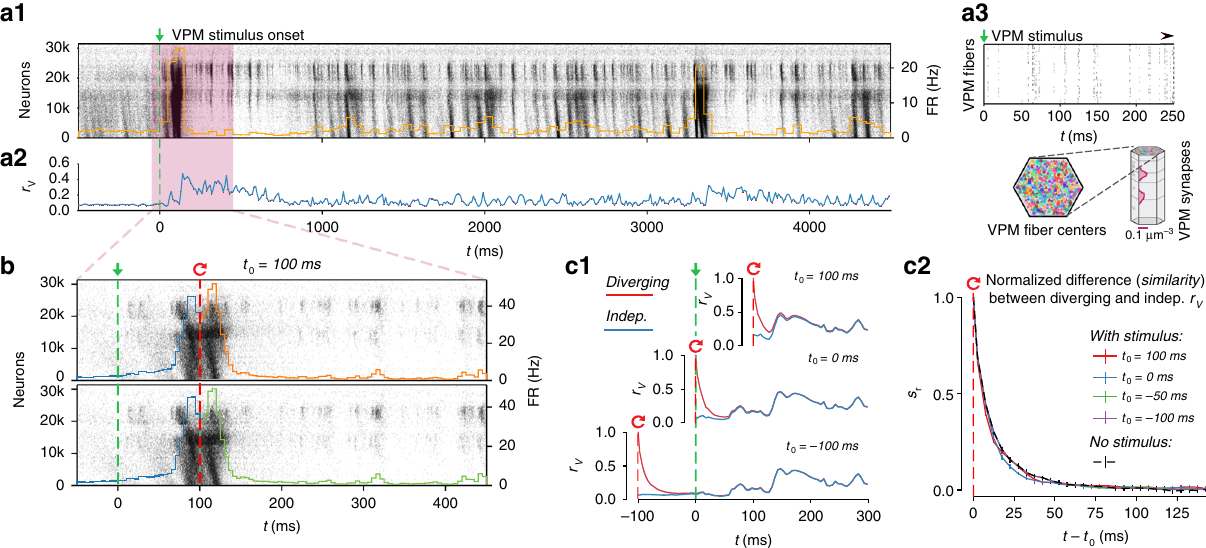
Fig. 5 Rapid divergence of evoked, reliable activity. a1 Population raster plot and population peristimulus time histogram (PSTH) for all 31,346 neurons in the microcircuit, during evoked activity with a thalamic (VPM) stimulus. Neurons are ordered according to cortical depth, with deep layers at the bottom and upper layers at the top, and each row representing the spikes of one neuron. For visibility, raster lines extend over dozens of rows for each neuron. a2 Mean somatic membrane potential correlation r V between independent simulations of the same VPM stimulus (mean ± 95% con fi dence interval). a3 Schematic of the VPM stimulus. Top: Raster plot spike times for the fi rst 250 ms of the thalamic stimulus. Bottom: 310 VPM fi ber centers are assigned 30 colors, and those with identical colors are provided with duplicate spike trains. The synapse density pro fi le across layers for each fi ber is shown to the right. b For t < 100, the top and bottom raster plots show the same simulation, whereas for t > 100, the raster plots depict two resumed simulations starting from the same saved state at t 0 = 100, using different random number seeds. c1 Resuming from identical initial conditions at different times: during (top), at onset (middle), or before the stimulus (bottom). Mean r V between independent simulations (blue, as in a2 ), and mean r V between simulations starting from the same base state (red; mean ± 95% con fi dence interval). c2 The similarity, s r , de fi ned as the difference between the r V of diverging and independent trials, normalized to lie between 1 (identical) and 0 (fully diverged) (mean ± 95% con fi dence interval). Means are based on 20 base states, no stimulus (spontaneous activity) on 40 as